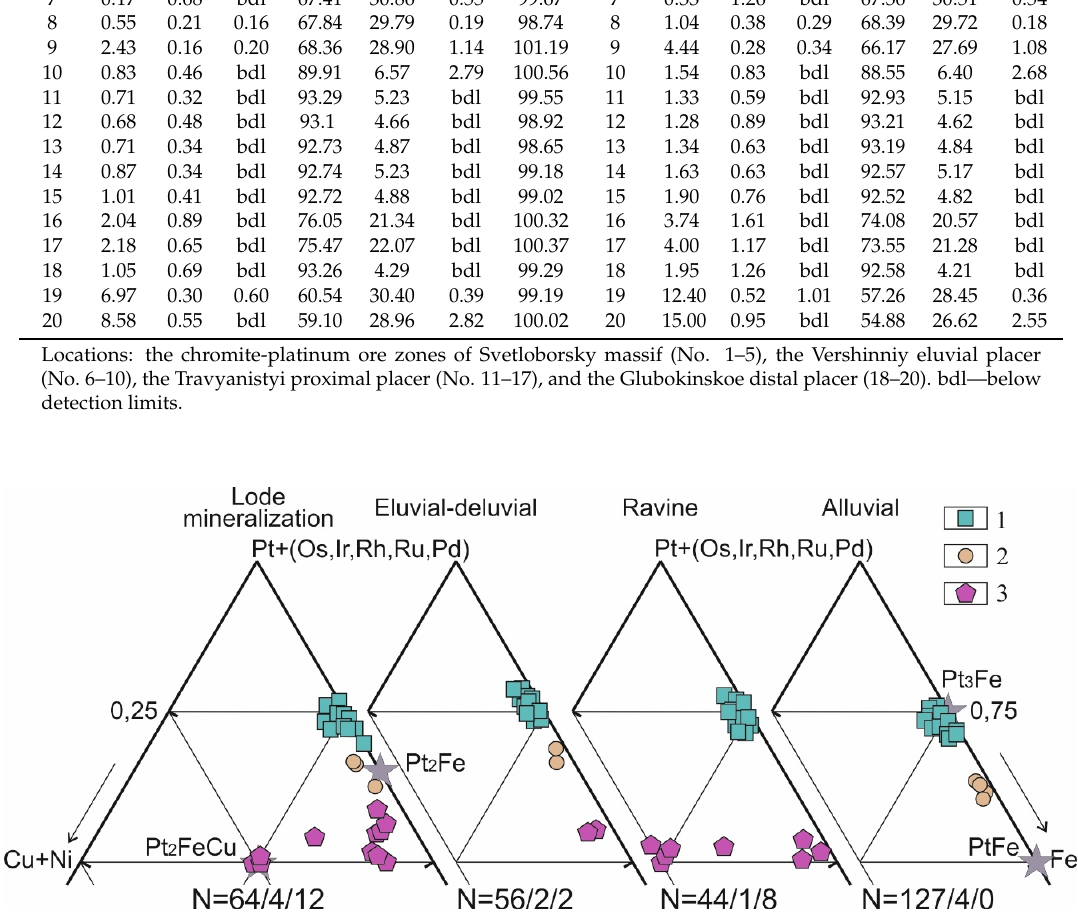
Figure 6. BSE images (SEM) of Pt-Fe aggregates from Vershinniy eluvial ( a , b ), Travyanistyi proximal ( c , d ) and Glubokinskoe distal ( e , f ) placers. The number of points corresponds to the data in Table 1